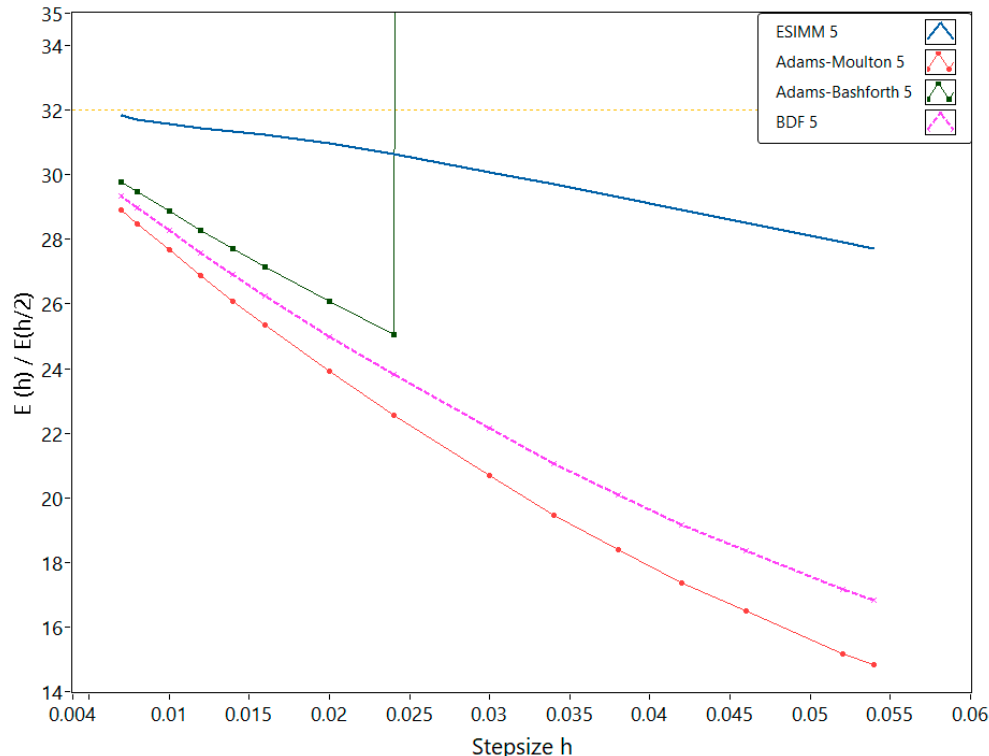
Figure 9. The order plots for investigated methods of order 5 while solving the Rossler problem. Note that the superiority of ESIMM methods over implicit solvers increases with the order of accuracy.